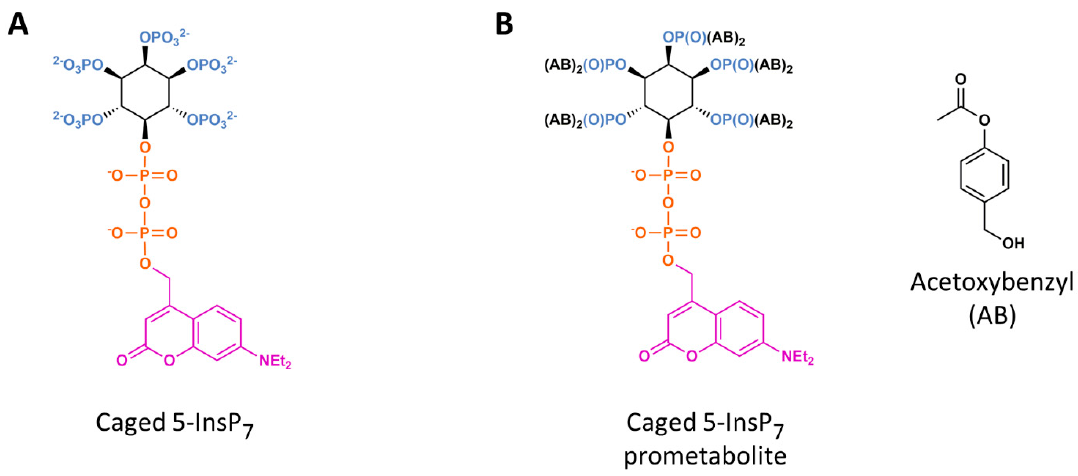
Figure 4. The structure of a ( A ) caged 5-InsP 7 and ( B ) its ‘prometabolite’.